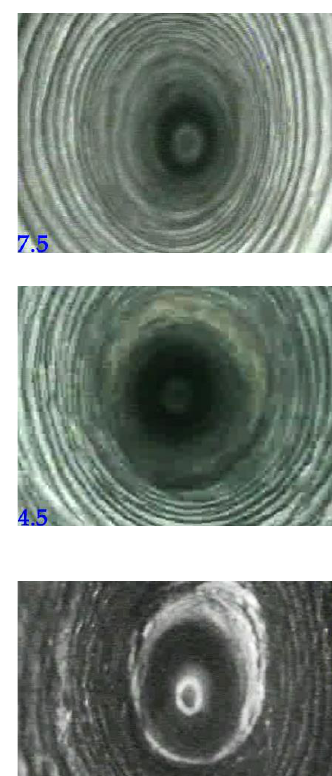
( b ) Figure 9. Observation scheme of deep failure of the surrounding rock (Unit: mm): ( a ) station ar- rangement positions; ( b ) peep borehole parameters. 5.1.2. Field Observation of Surface Displacement of the Surrounding Rock in the Main Roadway The number and location of stations for monitoring of surface displacement of sur- rounding rock in the main roadway were the same as those of borehole peeping stations.